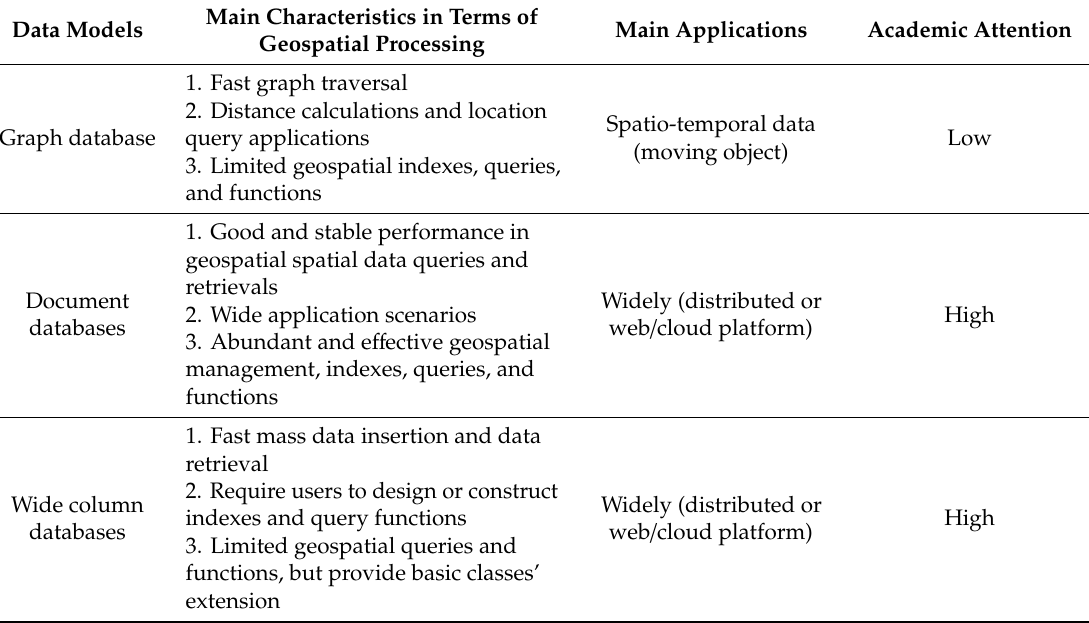
Table 5. A summary of geospatial processing in NoSQL